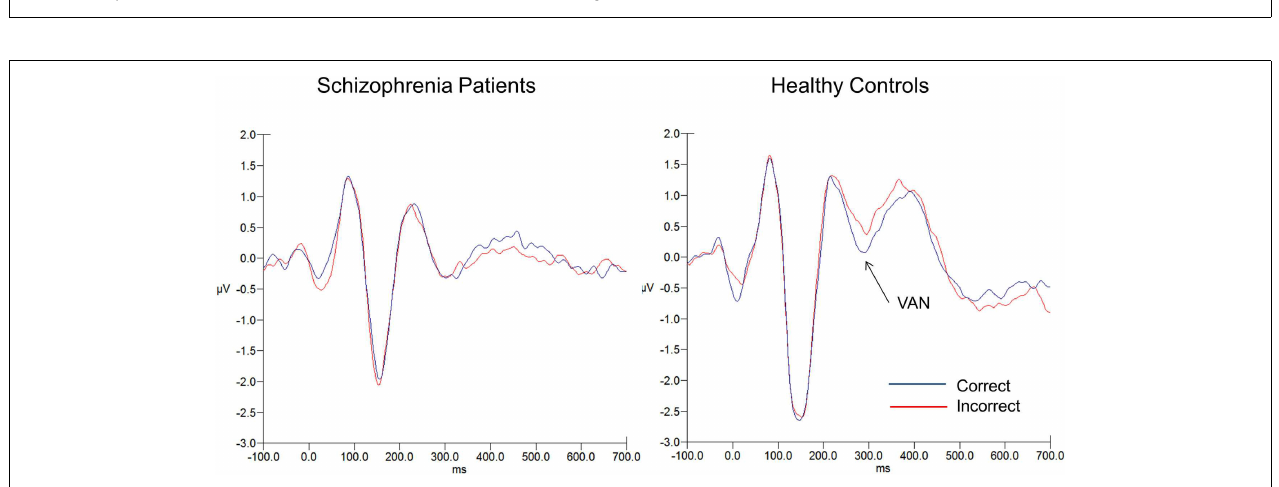
FIGURE 4 |VAN waveforms for correct (blue) and incorrect (red) responses for schizophrenia patients (on the left) and healthy controls (on the right). TheVAN was averaged over SOAs 50 and 100 (averaged over electrodes PO7, PO8, O1, O2).